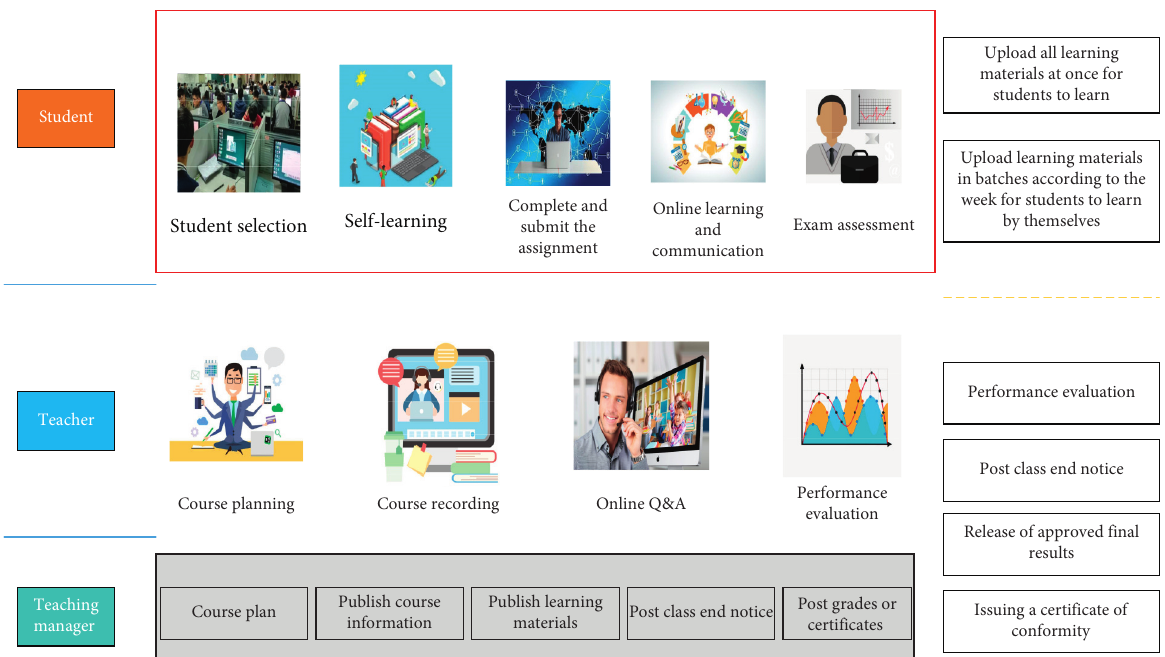
Figure 1: Schematic diagram of the main teaching activities of MOOC teaching mode.